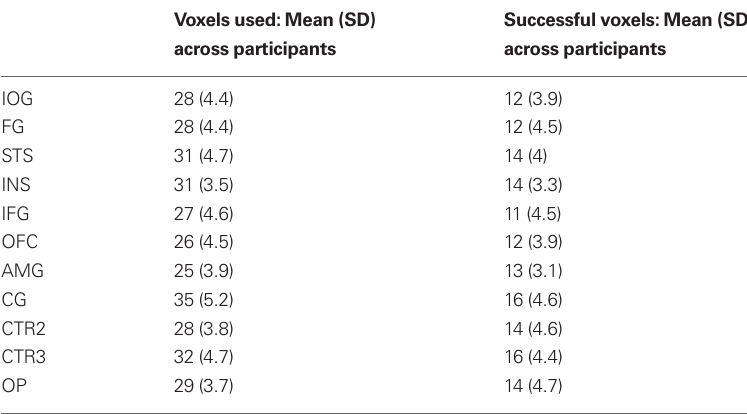
Table A3 | Number of voxels used and successful voxels per ROI.